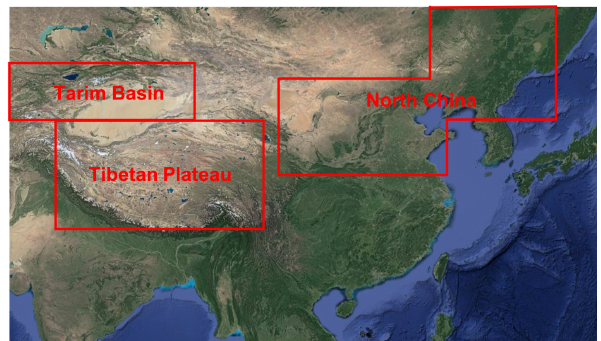
Figure 1. The three regions used in this study. The map was created in © Google Maps